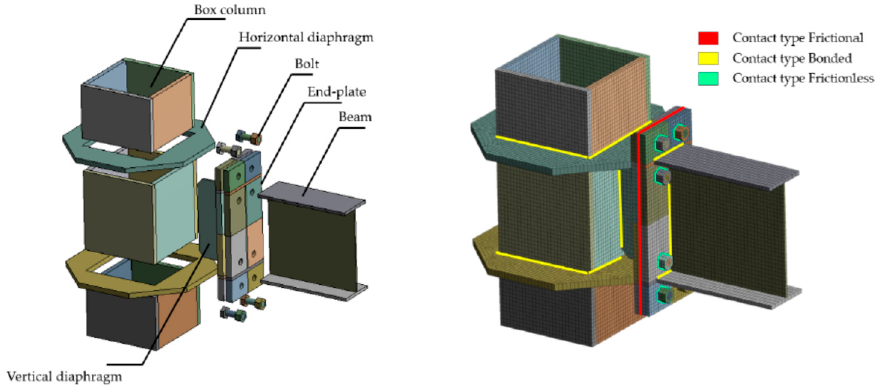
Figure 16. Figure 16. Numerical study of an EP-HSS connection with HSS beam and HSS column [166] repro- duced under the Creative Commons Attribution 4.0 International License, (http://creativecom- mons.org/licenses/by/4.0/).